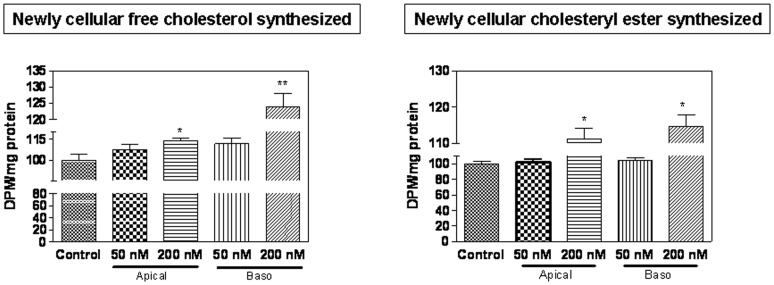
Effects of the administration of PYY (1–36) to the apical or basolateral medium on cholesterol synthesis.After 24 h incubation with [14C]-acetate, cells were homogenized. Lipids were extracted in chloroform/methanol and separated by TLC. The free cholesterol (FC) and cholesteryl ester (CE) bands were scraped off the plate and counted. Data represent means ± SD for n = 3 separate experiments in each group. *P<0.05 vs. controls, **P<0.01 vs. controls.